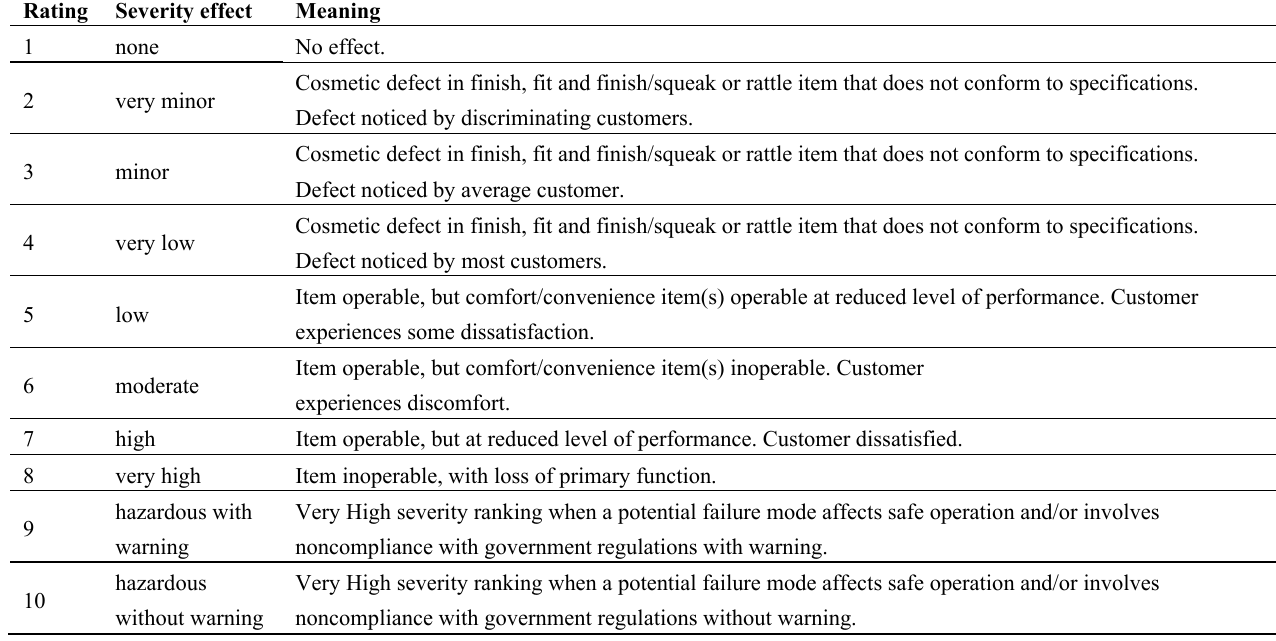
Table A2. FMEA ratings for severity of a failure ( S ) [10].